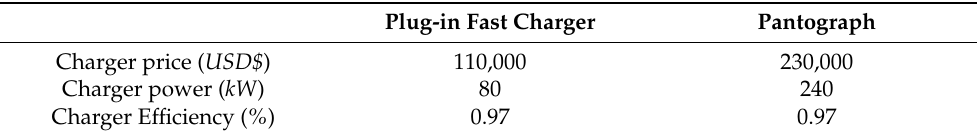
Table 2. Chargers considered for the electric